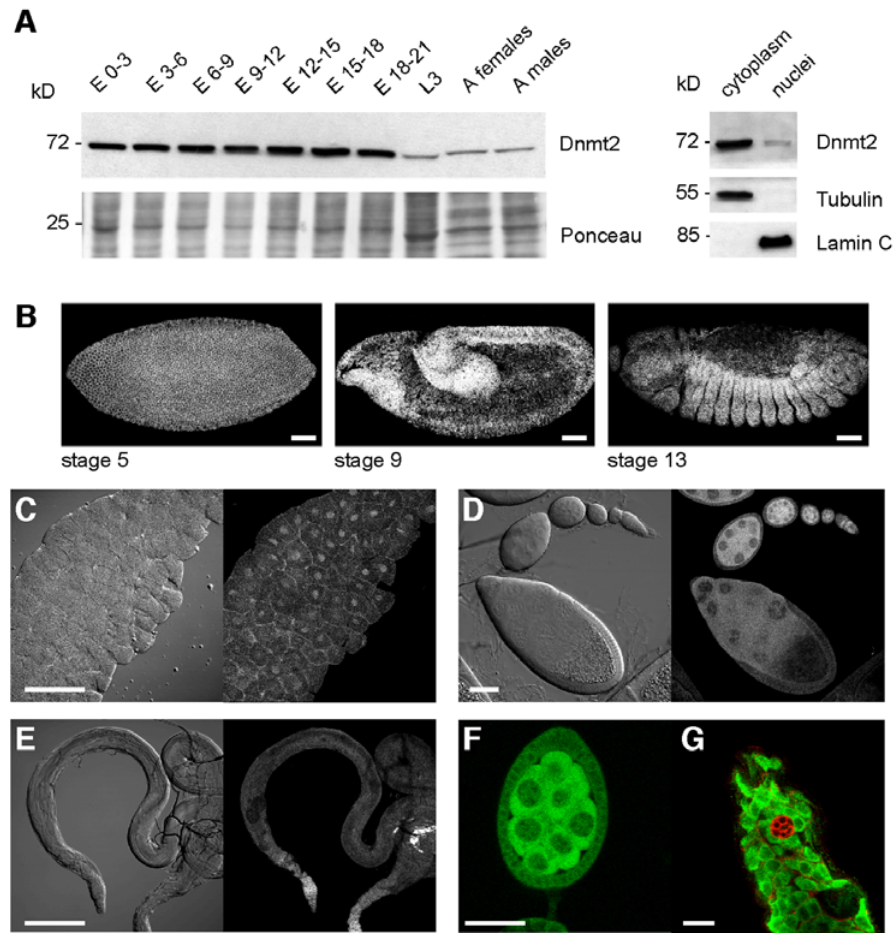
Figure 2. Tissue specific expression of Dnmt2. (A) Left panel: developmental Western blot of pGeno-Dnmt2-EGFP animals. Whole protein extract from embryonic, larval and adult stages were blotted and probed with anti-Dnmt2. Ponceau staining is shown as a loading control. Right panel: Dnmt2-EGFP is expressed both in the cytoplasm and in nuclei. Fractionation efficiency was confirmed by probing the blot for cytoplasmic ^ -tubulin and nuclear Lamin C. Antibodies against EGFP reveal Dnmt2 in developing embryos (B), third instar larval salivary glands (C), ovaries (D) and testes (E). (F) Dnmt2-EGFP in a developing cyst of the female germline is mostly cytoplasmic. Nuclear staining can be observed in nurse cell nuclei. (G) Dnmt2- EGFP in the male germline is ubiquitous in all cells with the exception of somatic hub cells (marked by Armadillo, red). Scale bars: (B) 100 m m; (C) 10 m m; (D) 50 m m; (E) 100 m m; (F) 20 m m; (G) 10 m m.